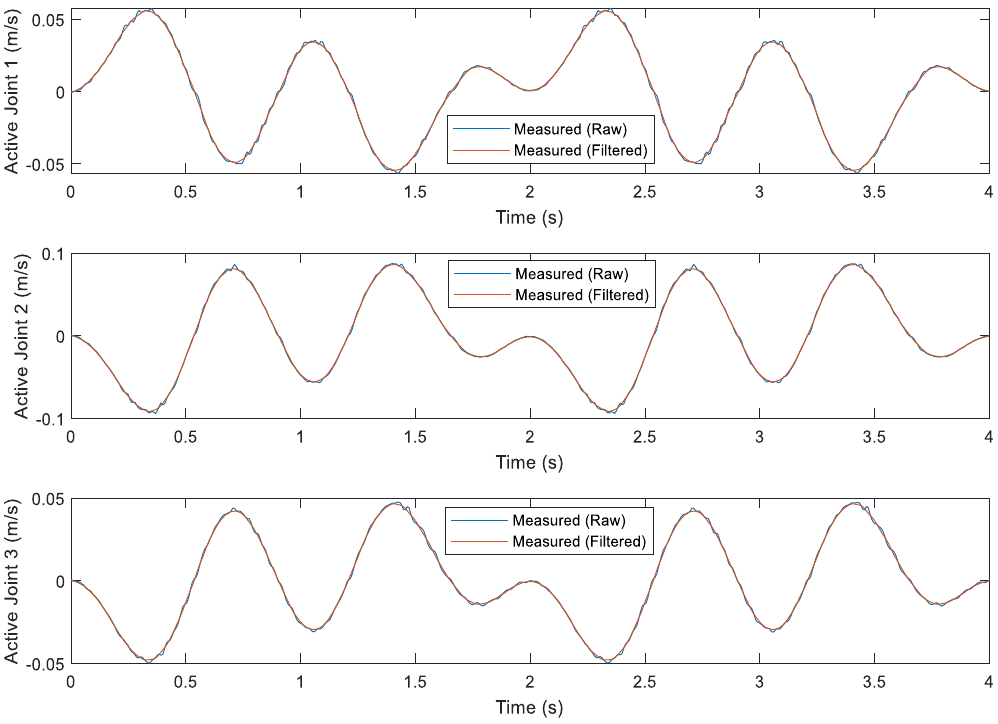
Figure 9. Raw and filtered measured active joint velocities.